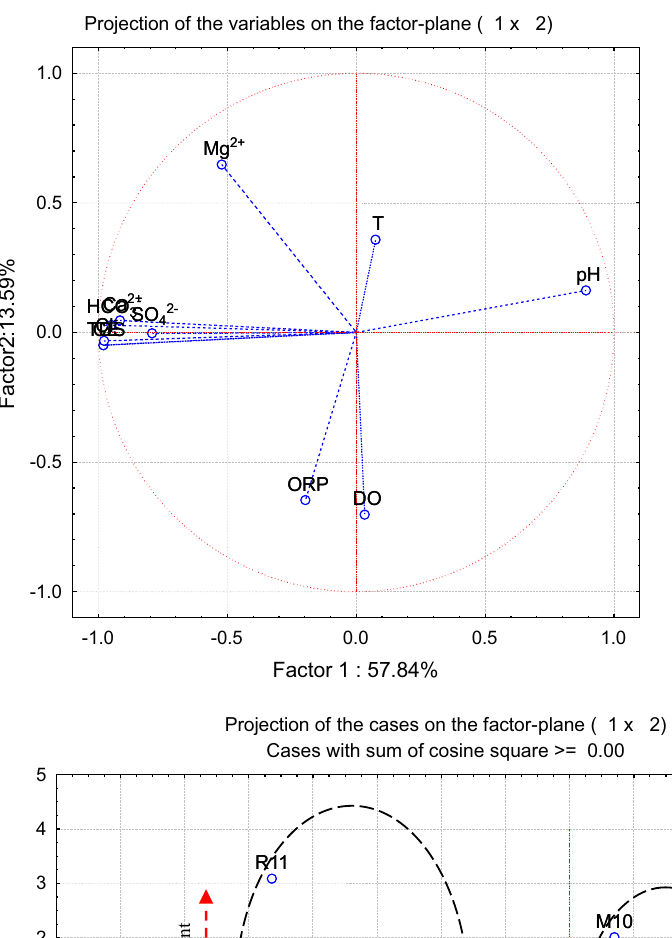
Fig. 3 PCA projections of vari- ables and observations